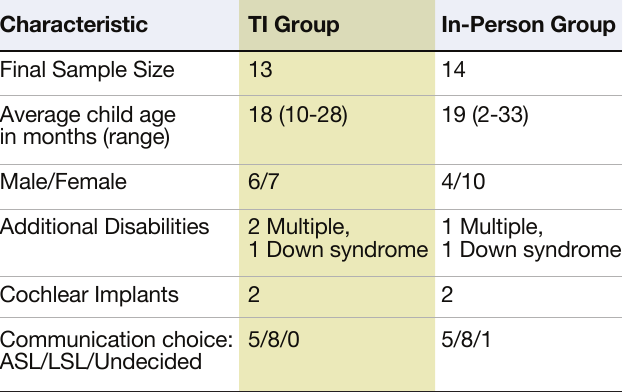
Table 1. Family and Child Characteristics at Beginning of Study Characteristic TI Group In-Person